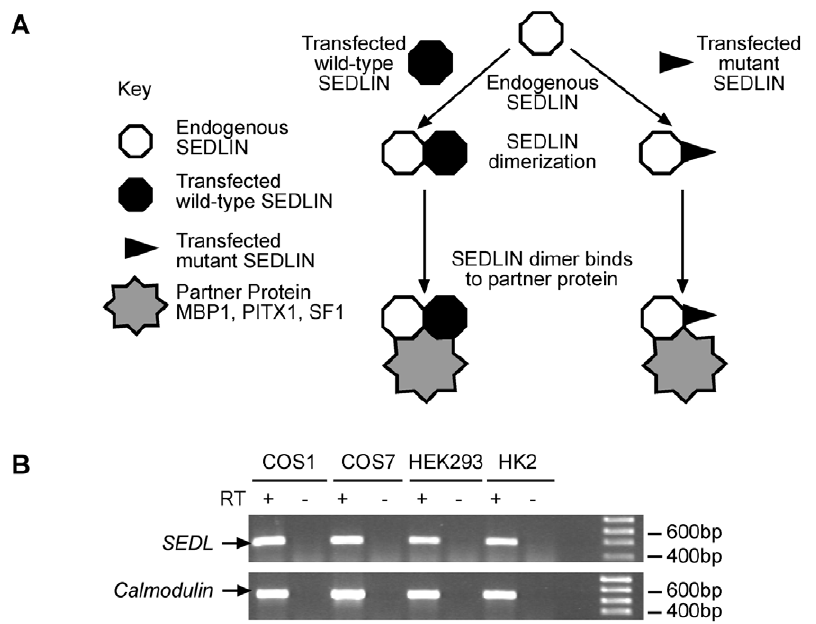
Figure 5. Schematic model for SEDLIN homodimerization and SEDL expression in common cell lines. (A) Homodimers that have formed between the transfected mutant cMyc-SEDLIN and the endogenously expressed wild-type SEDLIN could mask the loss of interaction between mutant SEDLINs and MBP1, PITX1 and SF1 in transfected COS7 cells. Thus, although the mutant SEDLIN may not directly interact with MBP1, PITX1 or SF1, the endogenously expressed SEDLIN will interact with these transcription factors, and hence the resultant homodimers will overall be seen to